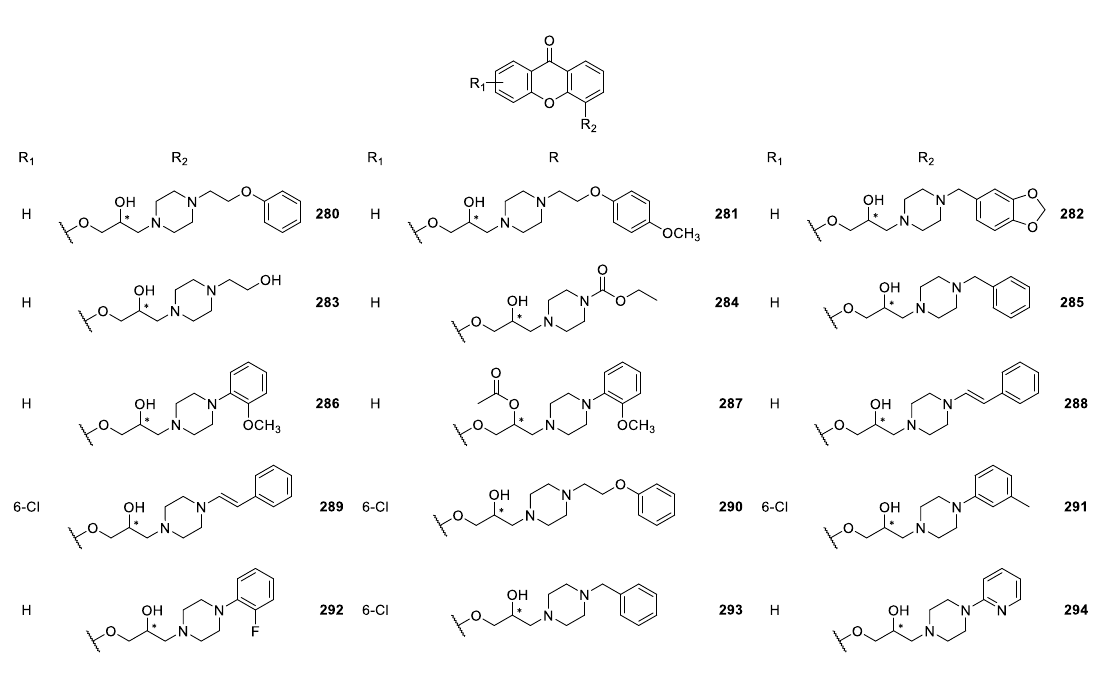
Figure 24. Structures of 4-piperazine derivatives 280 – 294 .